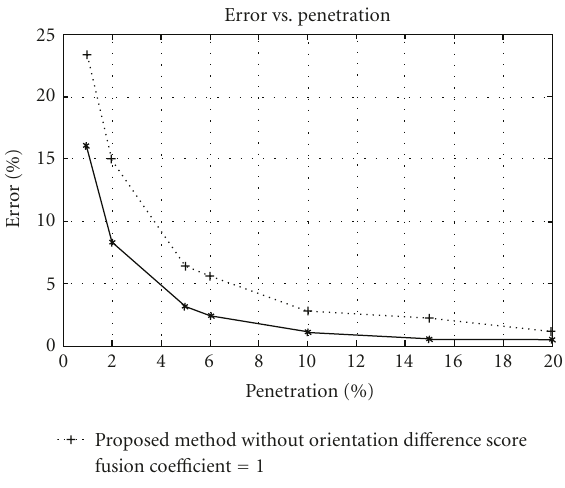
Figure 3: Percent of input fingerprints for which a match cannot be found in the first p fingerprint in database (producing error) versus penetration rate. One plot is for α = 1 and the other is for α = 0 . 5.